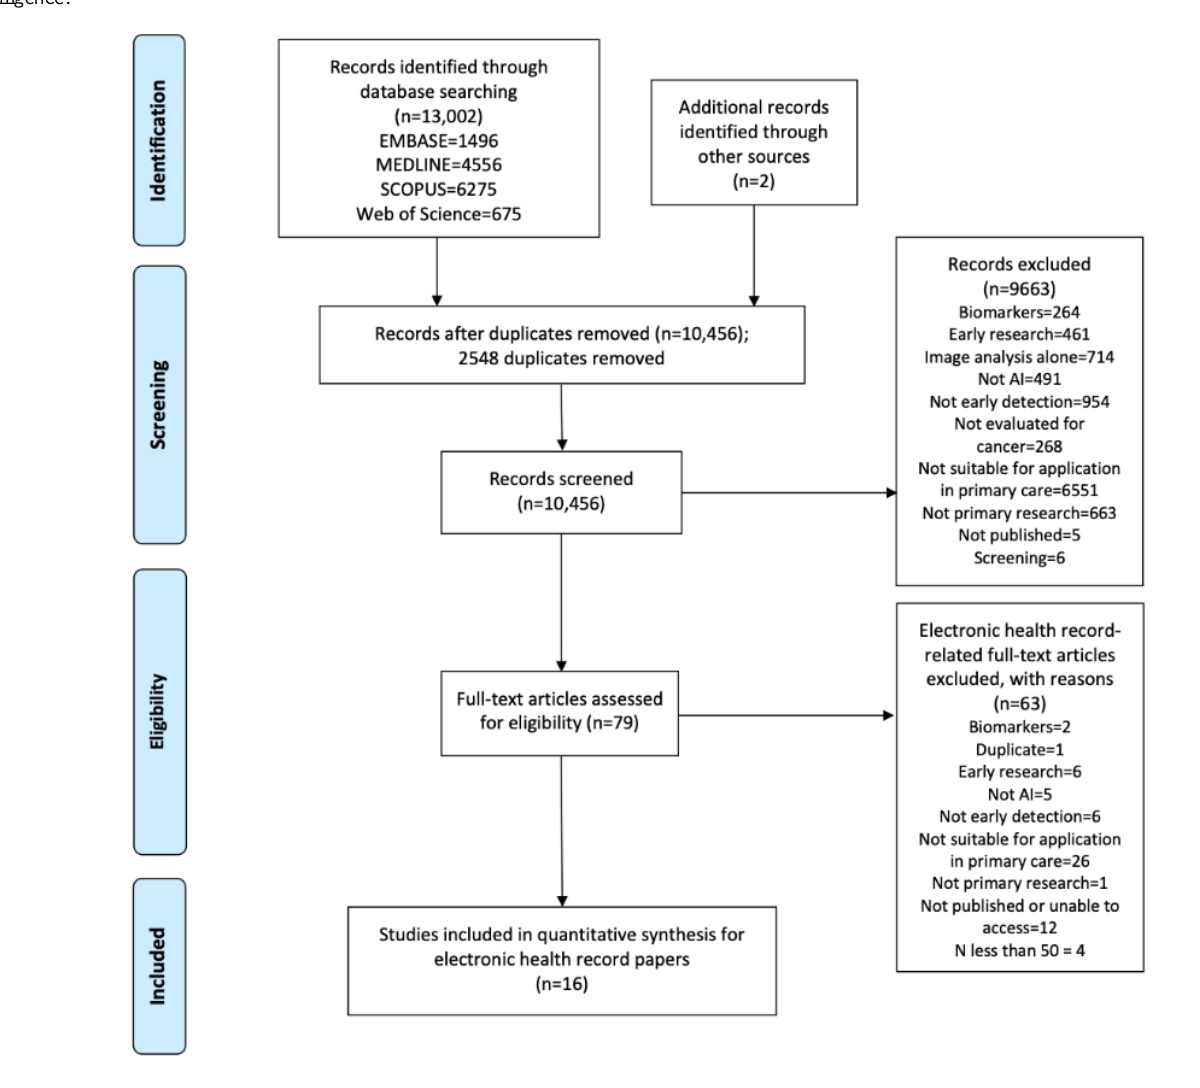
Figure 2. PRISMA (Preferred Reporting Items for Systematic Reviews and Meta-analysis) flow diagram for studies included in the review. AI: artificial